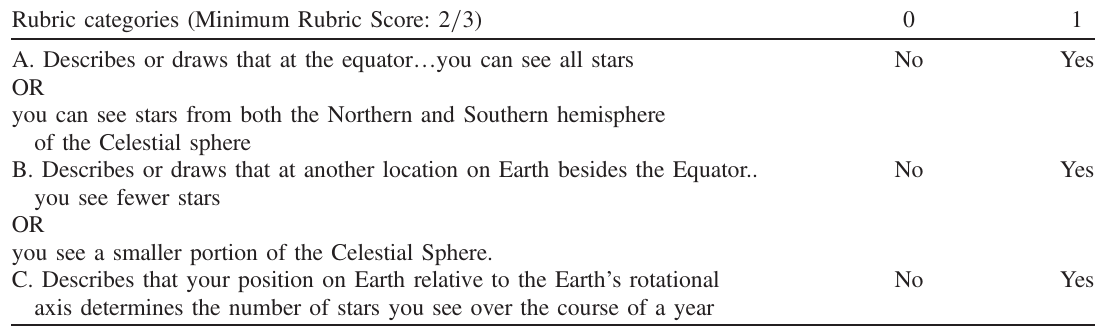
TABLE XIV. Rubric used to determine rubric scores for open-ended responses given to the assessment shown in Fig. 11.